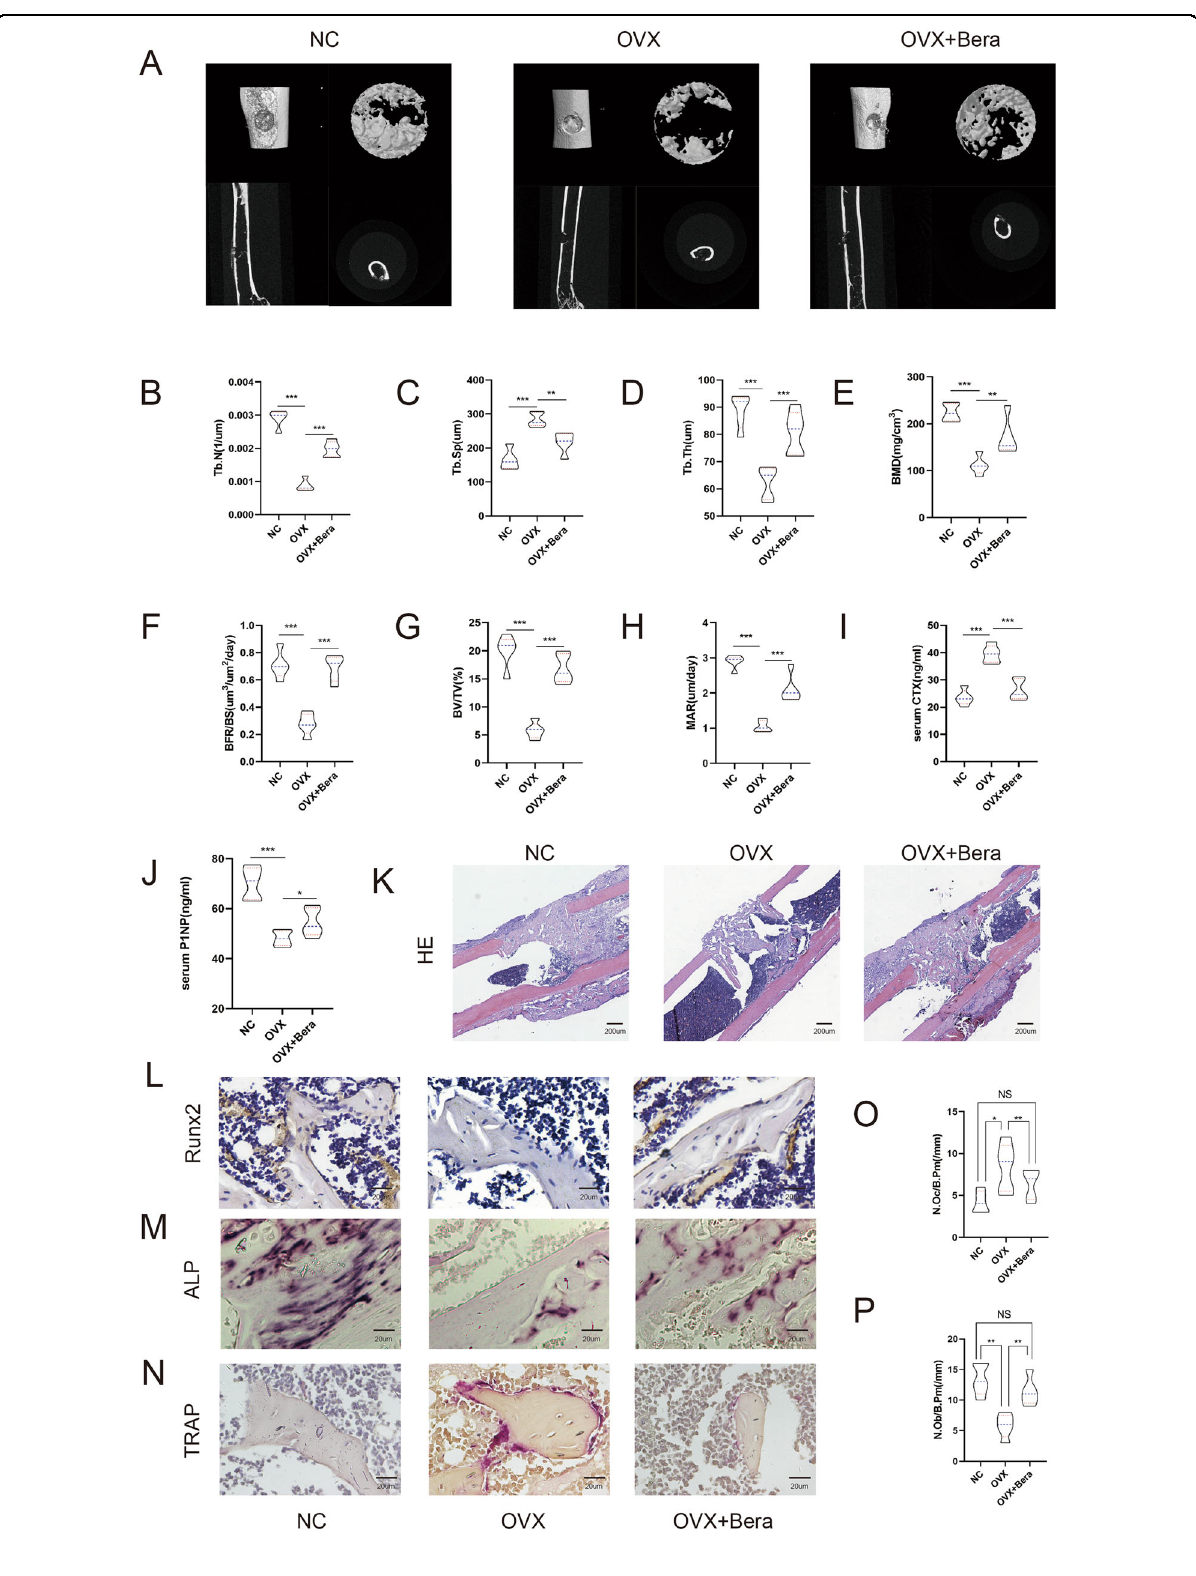
Fig. 2 (See legend on next